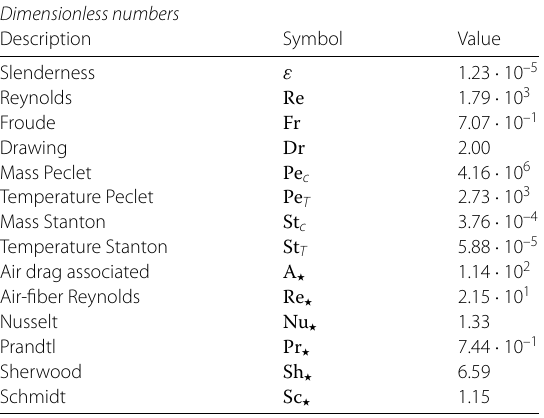
Table 4 Dimensionless numbers for one representative fiber (cf. Fig. 1) in the industrial dry spinning setup assuming the airflow without fibers (first step in the fiber-airflow coupling). Note that some dimensionless numbers might vary during the simulation due to the fiber-airflow interaction (cf. Dimensionlessnumbers